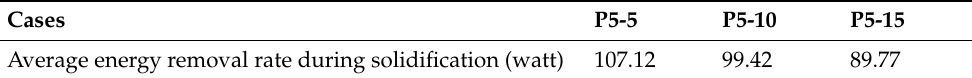
Table 8. The energy removal rate during solidification in the cases of P5-5, P5-10, and